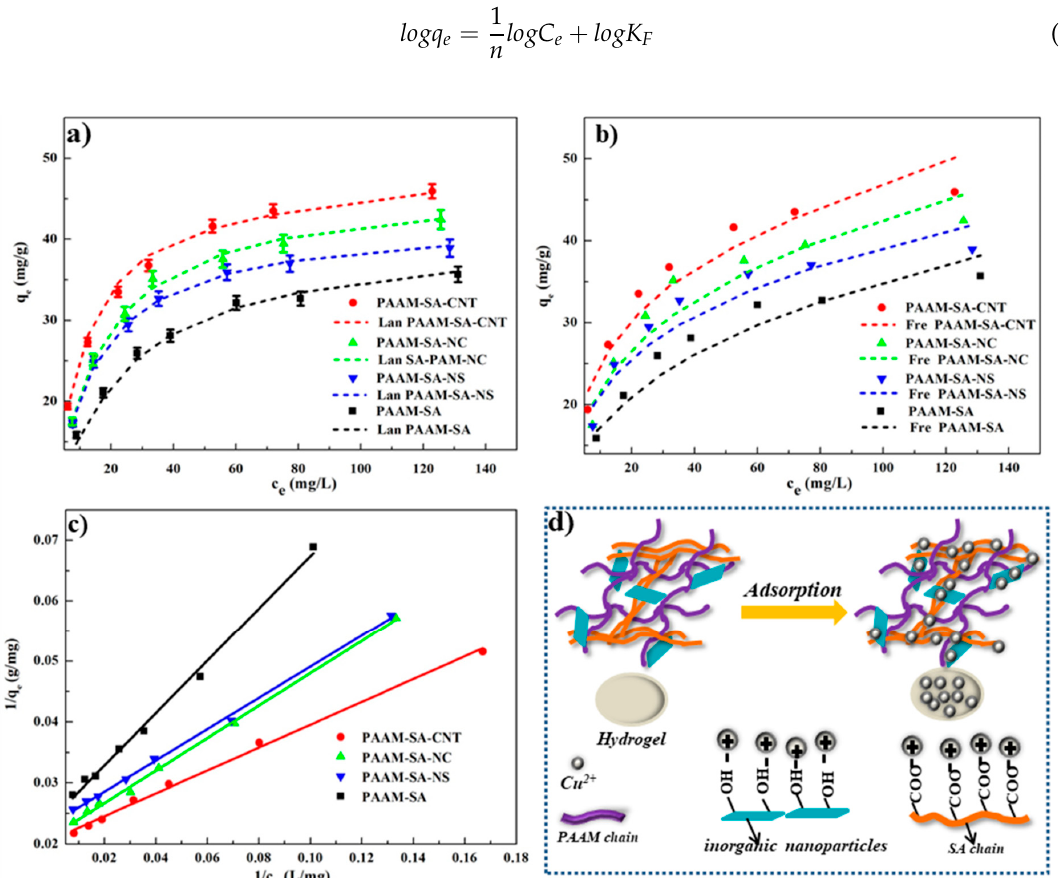
Figure 7. The adsorption capacity of hydrogels: ( a ) Langmuir adsorption isotherms and experimental results of Cu 2+ on hydrogels; ( b ) Freundlich adsorption isotherms and experimental results of Cu 2+ on hydrogels; ( c ) linearized Langmuir isotherms determined from 1/q e versus 1/c e ; and ( d ) mechanism of Cu 2+ adsorption on hydrogels.